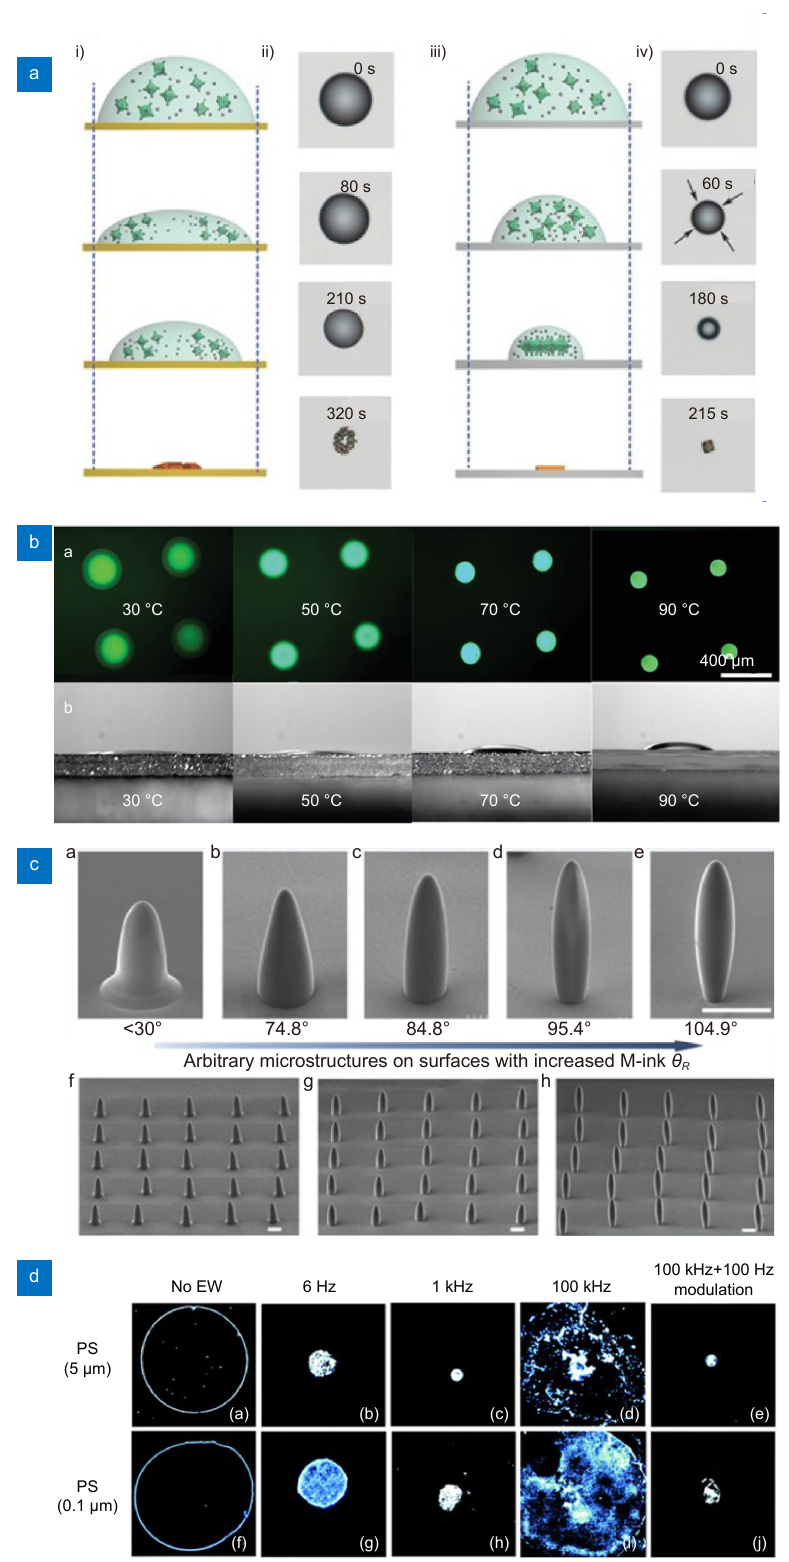
Fig. 13 | ( a ) Schematic illustration and optical microscopy images of the perovskite precursor droplet crystallizing on high and low adhesion sub- strates 62 . ( b ) The fluorescence and the contact angle images of resulting microdisks printed at different temperatures from 30 to 90 °C 69 . ( c ) Con- trollability of 3D microstructures by IJP on surfaces with tunable dewettability 130 . ( d ) Suppression of the coffee stain effect illustrated with different materials at three frequencies and amplitude modulation 131